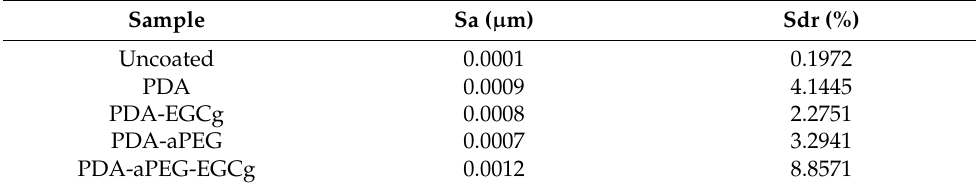
Table 3. Surface roughness of mica and of mica after sequential coating steps, as expressed by vertical Sa (arithmetical mean height) and hybrid Sdr (developed interfacial area ratio) roughness parameters.